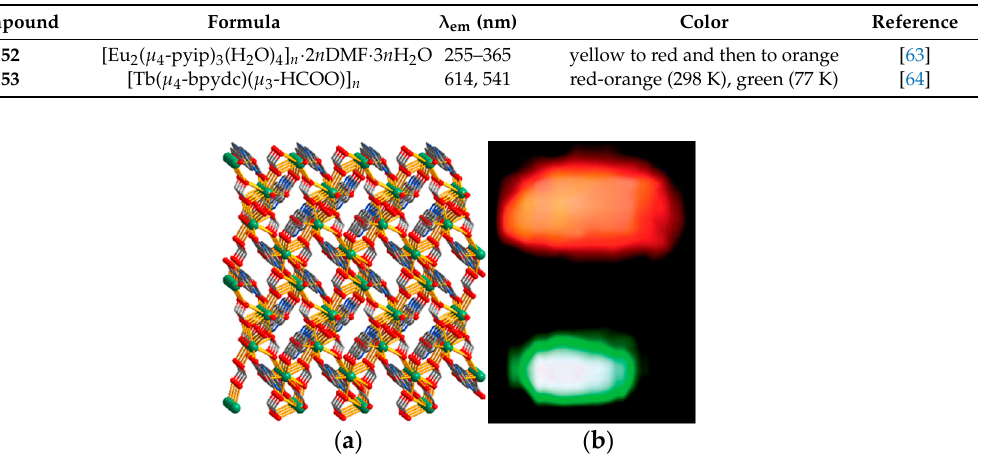
Table 9. Selected examples of highly luminescent MOFs.